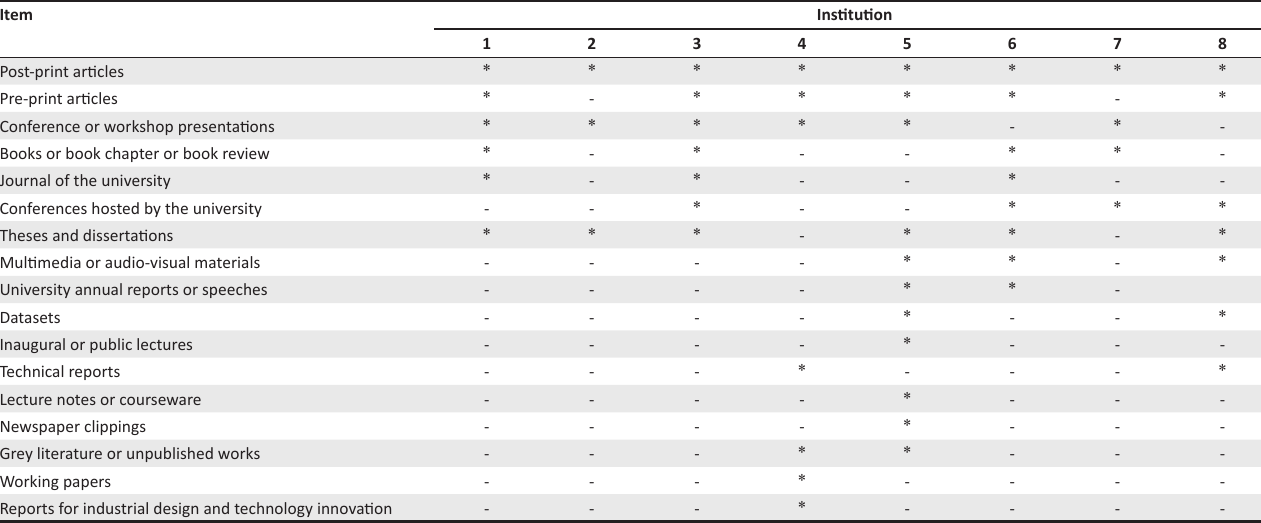
TABLE 1: Content type in the institutional repositories.